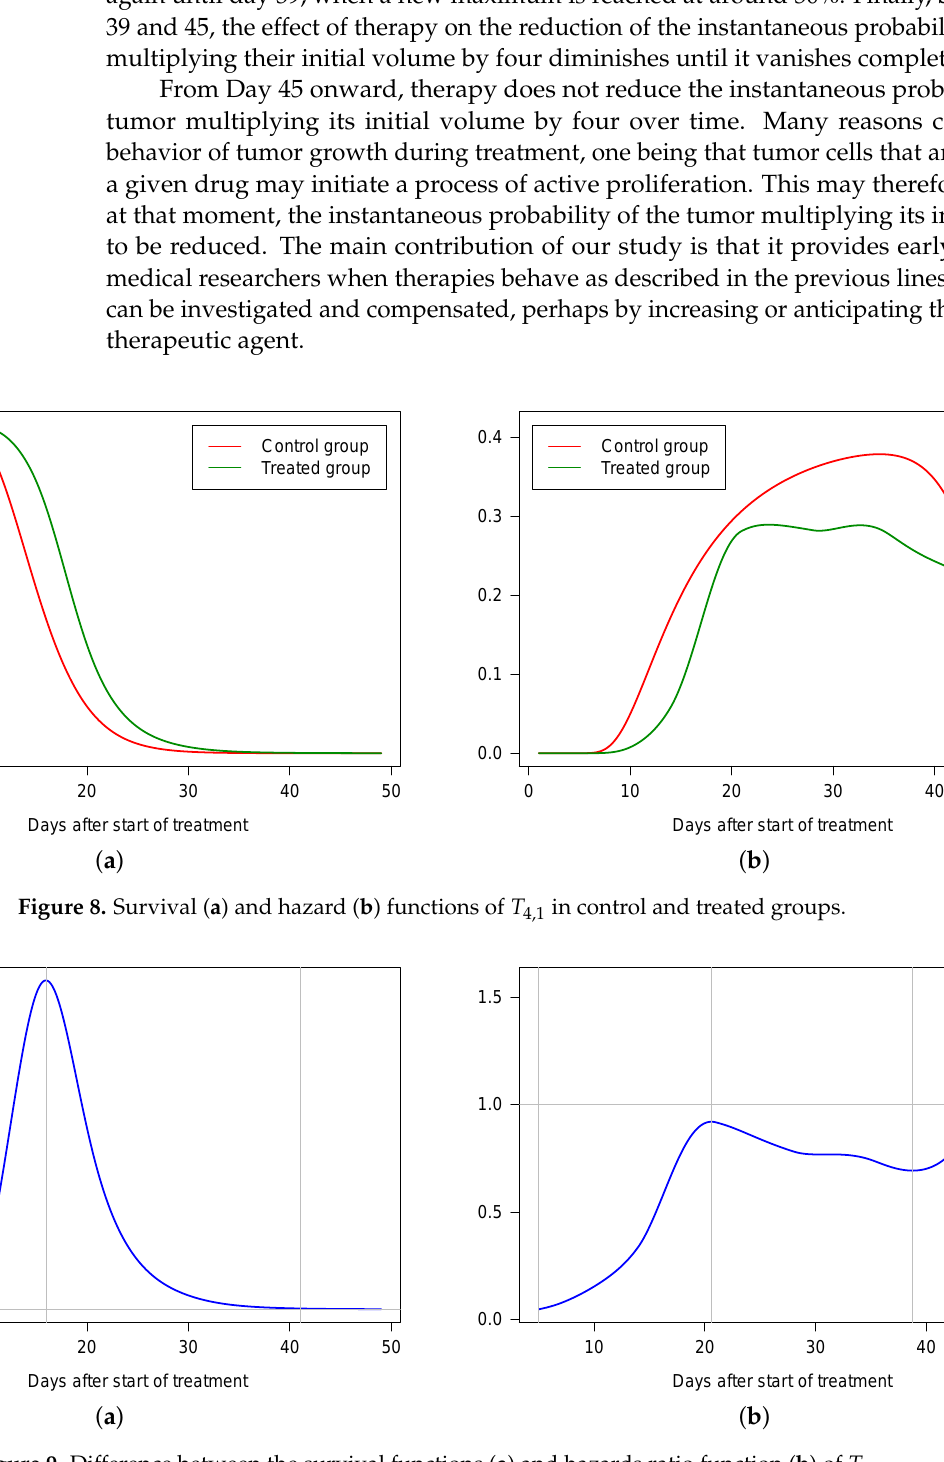
Figure 9. Difference between the survival functions ( a ) and hazards ratio function ( b ) of T 4,1